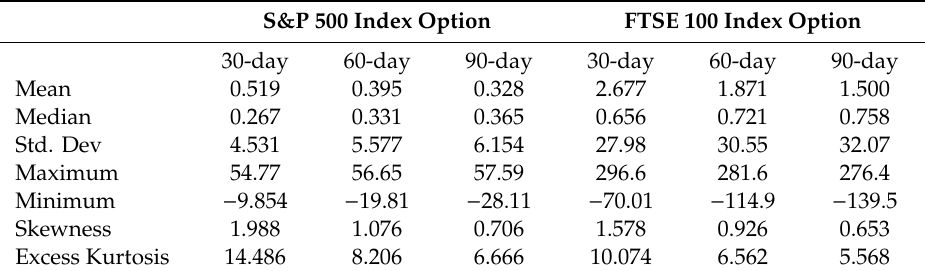
Table 1. Summary statistics for the P&L of the index options.